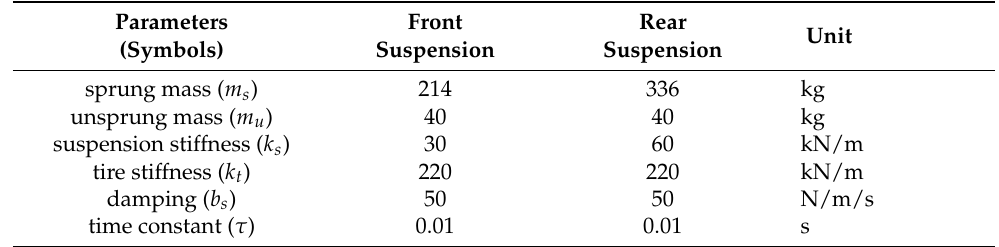
Figure 2. Control-oriented quarter-car model. Table 1. Suspension